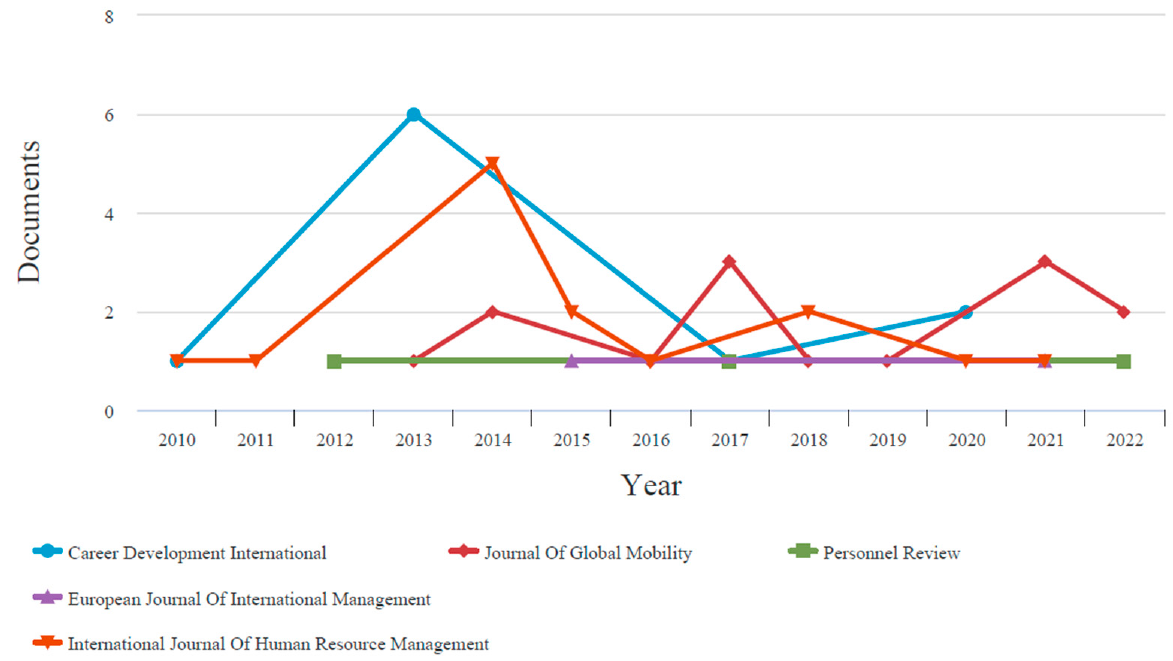
Figure 8. Self-initiated expatriation documents per year by source. Source: Data obtained from Scopus (August 2022).